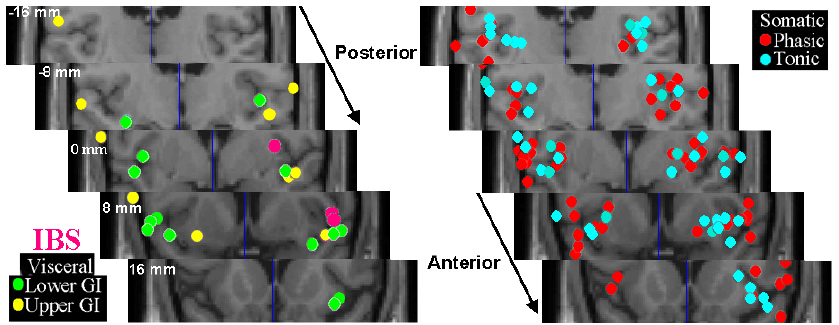
FIGURE 7. The center of each activation locus along the posterior-anterior extent of the insula. The color coding is shown in the key box and is as for Figs. 5 and 6. The arrows show the direction from posterior to anterior for the two posterior (behind the anterior commisure) and anterior (in front of the anterior commisure) slices as labeled. The most posterior section shows the responses –16 mm behind the anterior commisure, the most anterior section 16 mm anterior to the anterior commisure.